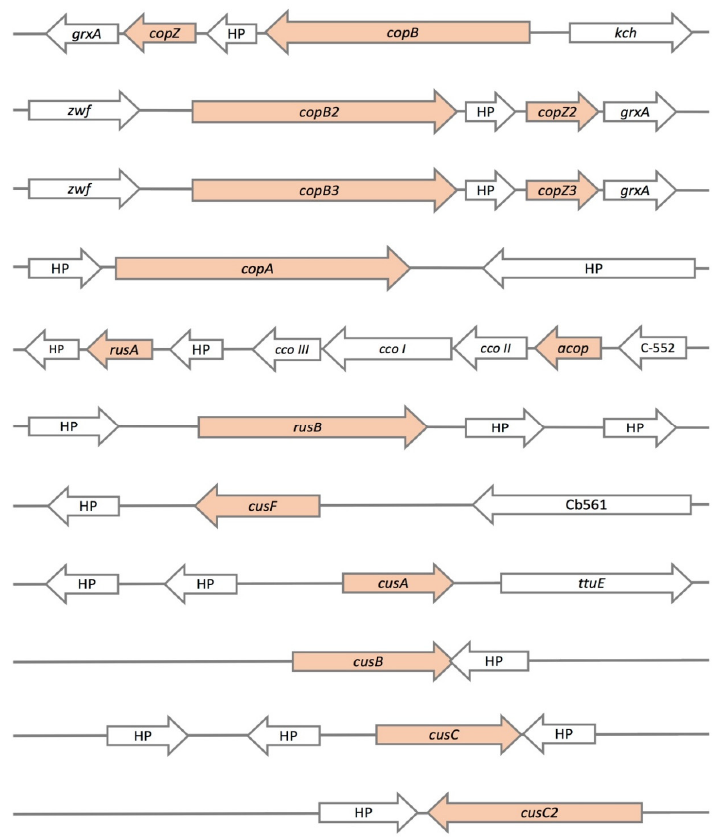
Figure 2. Presence and genomic context of copper resistance genes found on the A. ferrivorans ACH genome. copZ : metallochaperone; HP: hypothetical protein; copB : ATPase P-type; kch : potassium channel; zwf : glucose-6-phosphate-dehydrogenase; grxA : glutaredoxin; copA : ATPase P-type; rusA : rusticyanin A; cco III: cytochrome c oxidase polypeptide III; cco I: cytochrome c oxidase polypeptide I; cco II: cytochrome c oxidase polypeptide II; acop : cupredoxin; C-552: cytochrome c 552; rusB : rusticyanin B; cusF : periplasmic metallochaperone; cb561: cytochrome b561; cusA : inner membrane transporter (RND family); ttuE : Pyruvate kinase; cusB : periplasmic adaptor factor protein (membrane fusion protein (MFP) family); cusC : outer membrane factor (OMF).